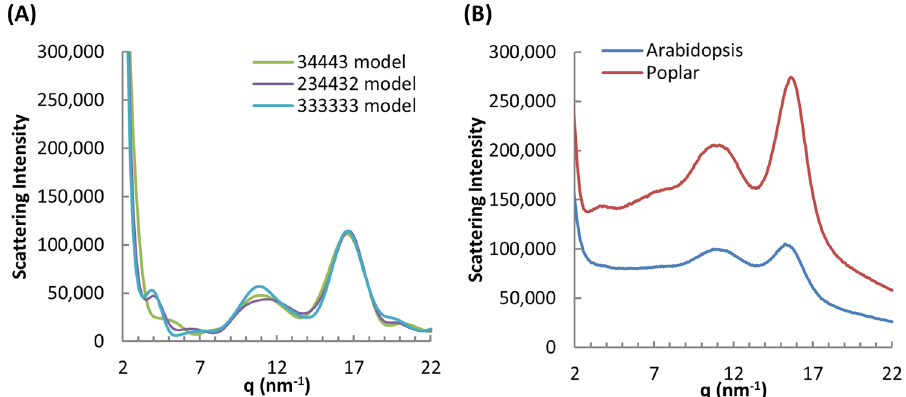
Figure 2. Simulated and experimental WAXS diffractograms for cellulose I. ( A ) All three CMF habits predict similar peaks near 10 to 11 and 16 nm − 1 . The 34443 model is distinct however in not producing a WAXS peak near 4 nm − 1 . ( B ) Wide-angle X-ray scattering from Arabidopsis and